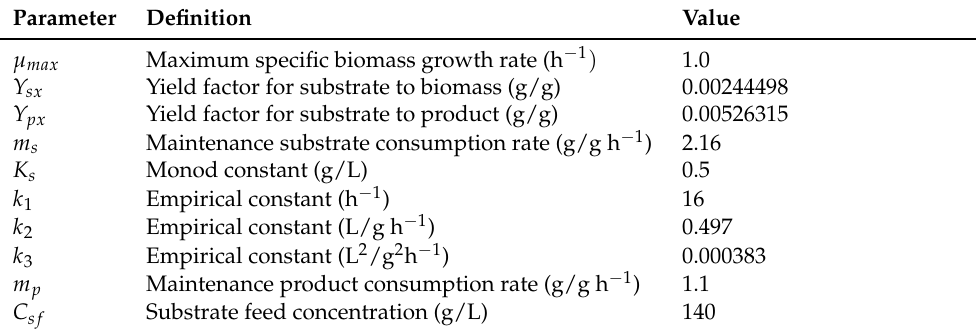
Table 1. Parameters used for the continuous bio-ethanol reactor model.